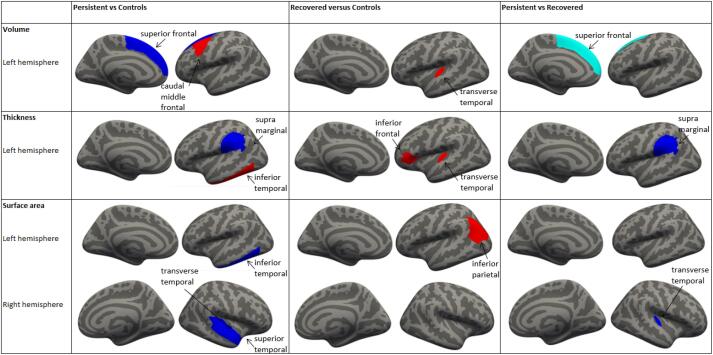
Gray matter morphometry differences associated with stuttering, red = positive, did not survive FDR; yellow = positive, pFDR < 0.05; dark blue = negative, did not survive FDR; light blue = negative, pFDR < 0.05.